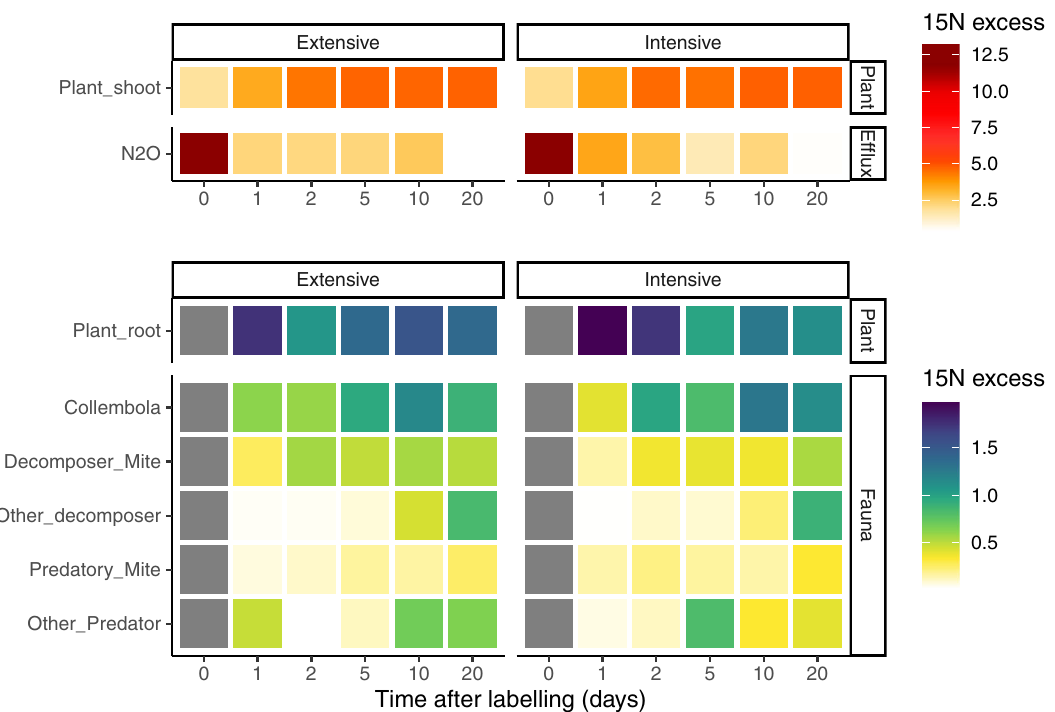
Fig. 5 | Management impact on the 15 N transfer in the plant-soil system. Tem- poral dynamics of 15 N atom % excess above-ground (upper panel) and below- ground (lower panel) in plant and soil fauna following 15 N pulse labelling from the control plots ( n =108). The heat map shows the 15 N atom % excess in the different groups in grassland under extensive (left) or intensive (right) management. Note difference in scales between the two panels as the enrichment of above-ground